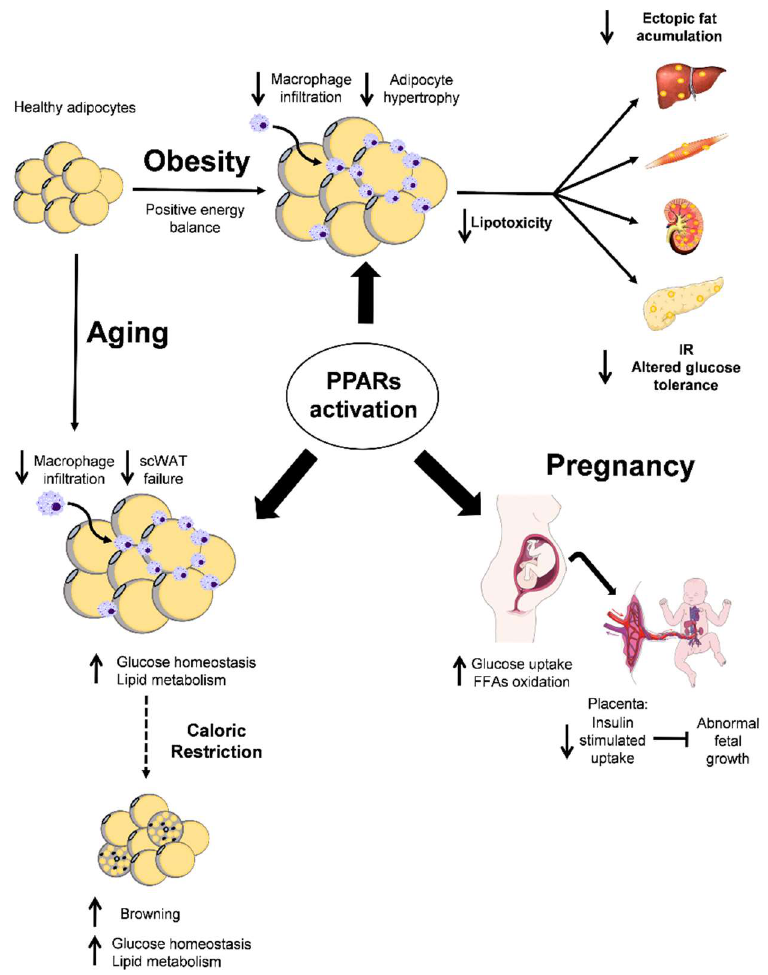
Figure 1. Overview of the effects of peroxisome proliferator-activated receptors (PPARs) activation in obesity, pregnancy, and aging. In obesity, PPARs activation decreases fibro-inflammation and ectopic fat accumulation in the adipose tissue (AT). In pregnancy, PPARs activation stimulates glucose uptake and fatty acid oxidation in the mother, while the placenta decreases insulin uptake to ameliorate abnormal fetal growth. In aging, this PPARs activation increases the glucose uptake and lipid metabolism in the subcutaneous white AT (scWAT). Moreover, both PPARs activation and caloric restriction (CR, dotted arrow) in aging promote browning in the AT, which improves the whole-body metabolism. The final effect of PPARs activation in all situations is the improvement of insulin resistance (IR). PPARs activation; effects or PPARs activation; CR effect; inhibition; increase or decrease effect.